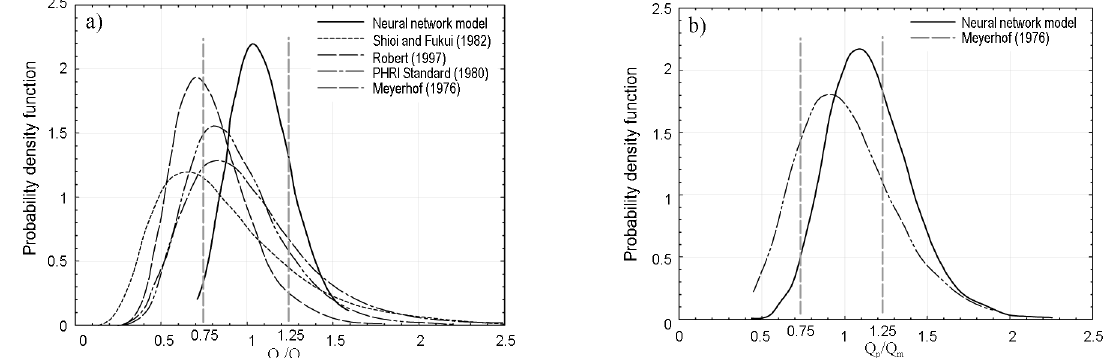
Fig. 11. Performance of ANN model against available SPT-based methods: (a) large-displacement piles, (b) low-displacement piles